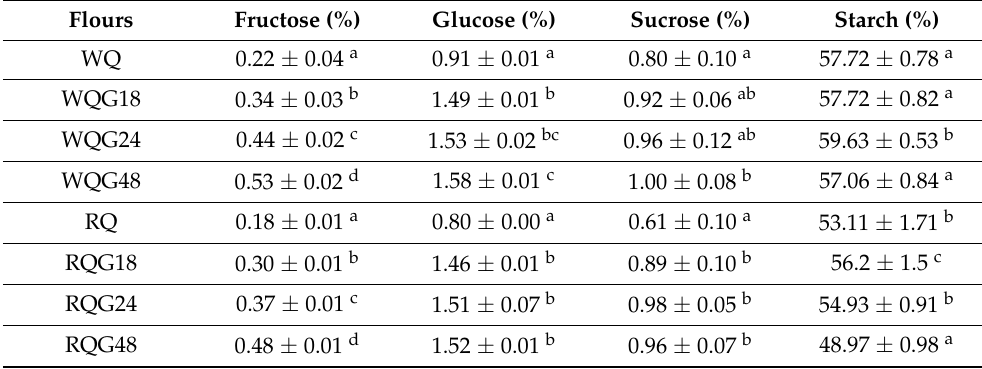
Table 1. Available carbohydrate content of ungerminated and sprouted white and red quinoa flours. Flours Fructose (%) Glucose (%) Sucrose (%) Starch (%)